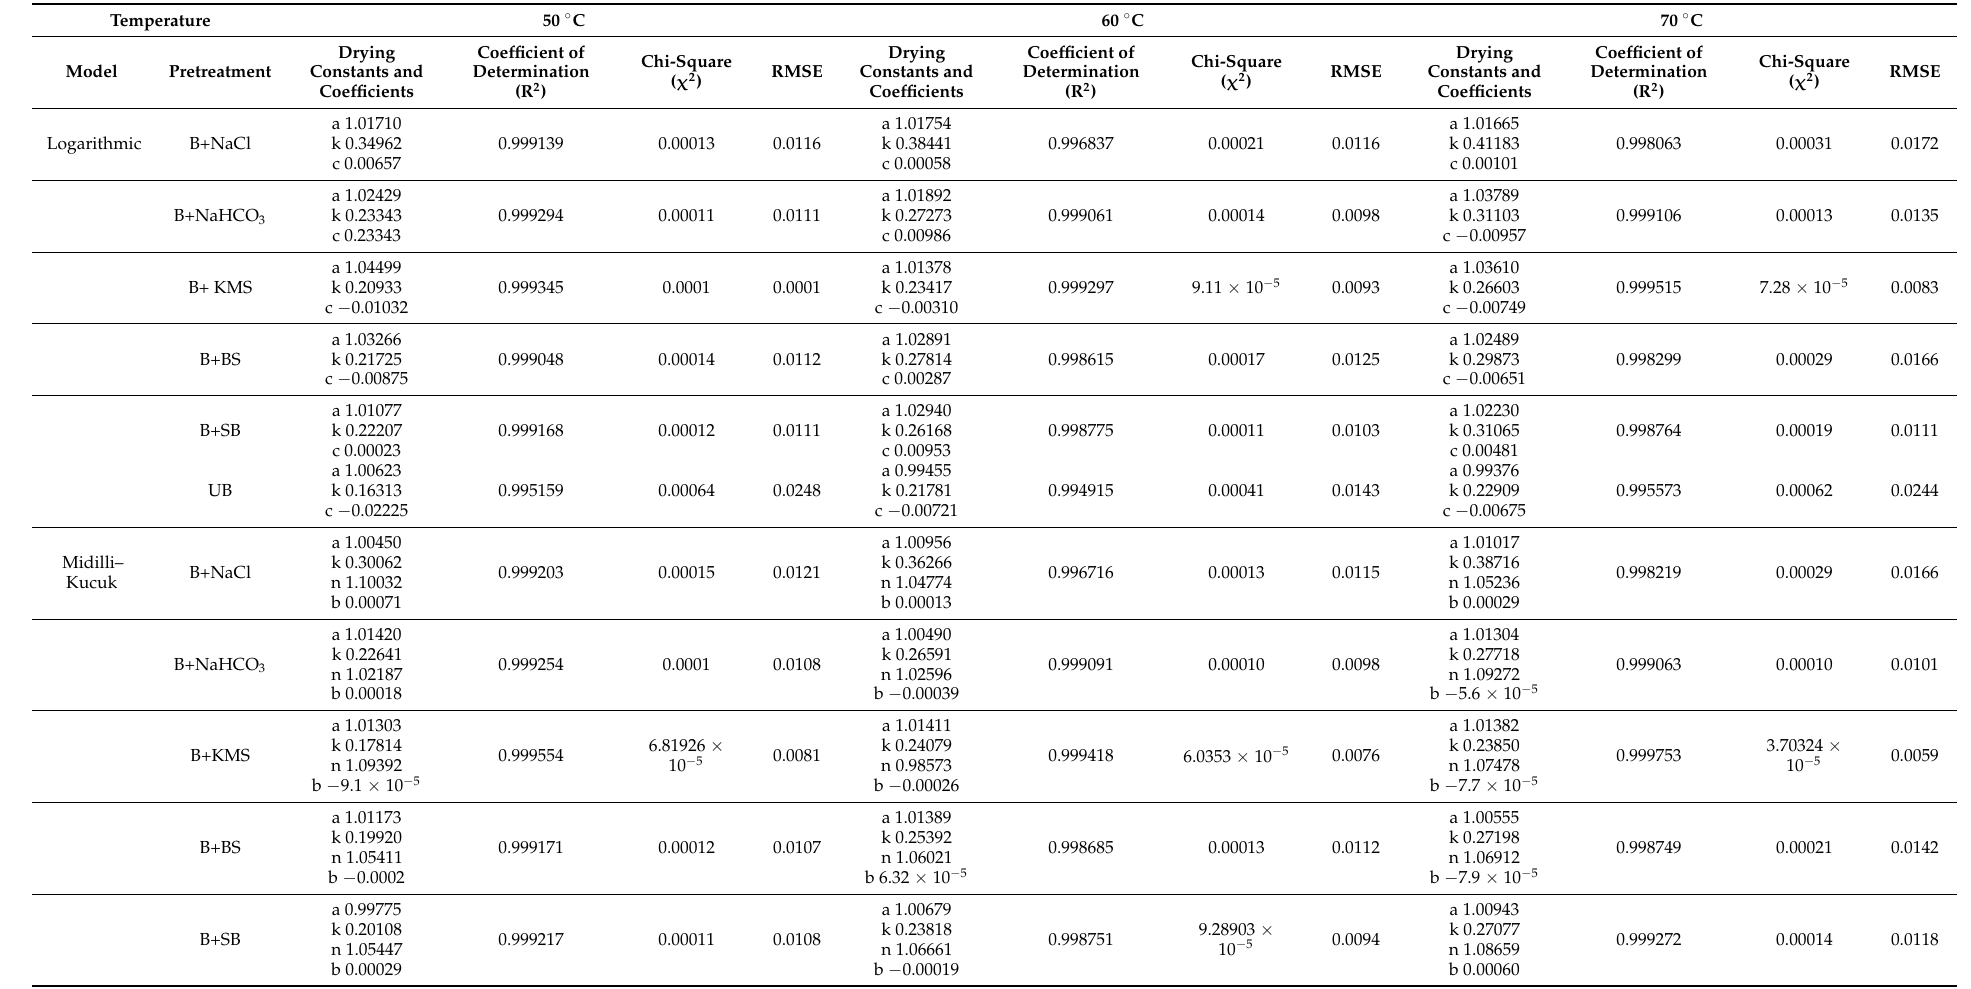
Table 3. Statistical analysis of different thin layer models of Moringa leaves under fluidized bed